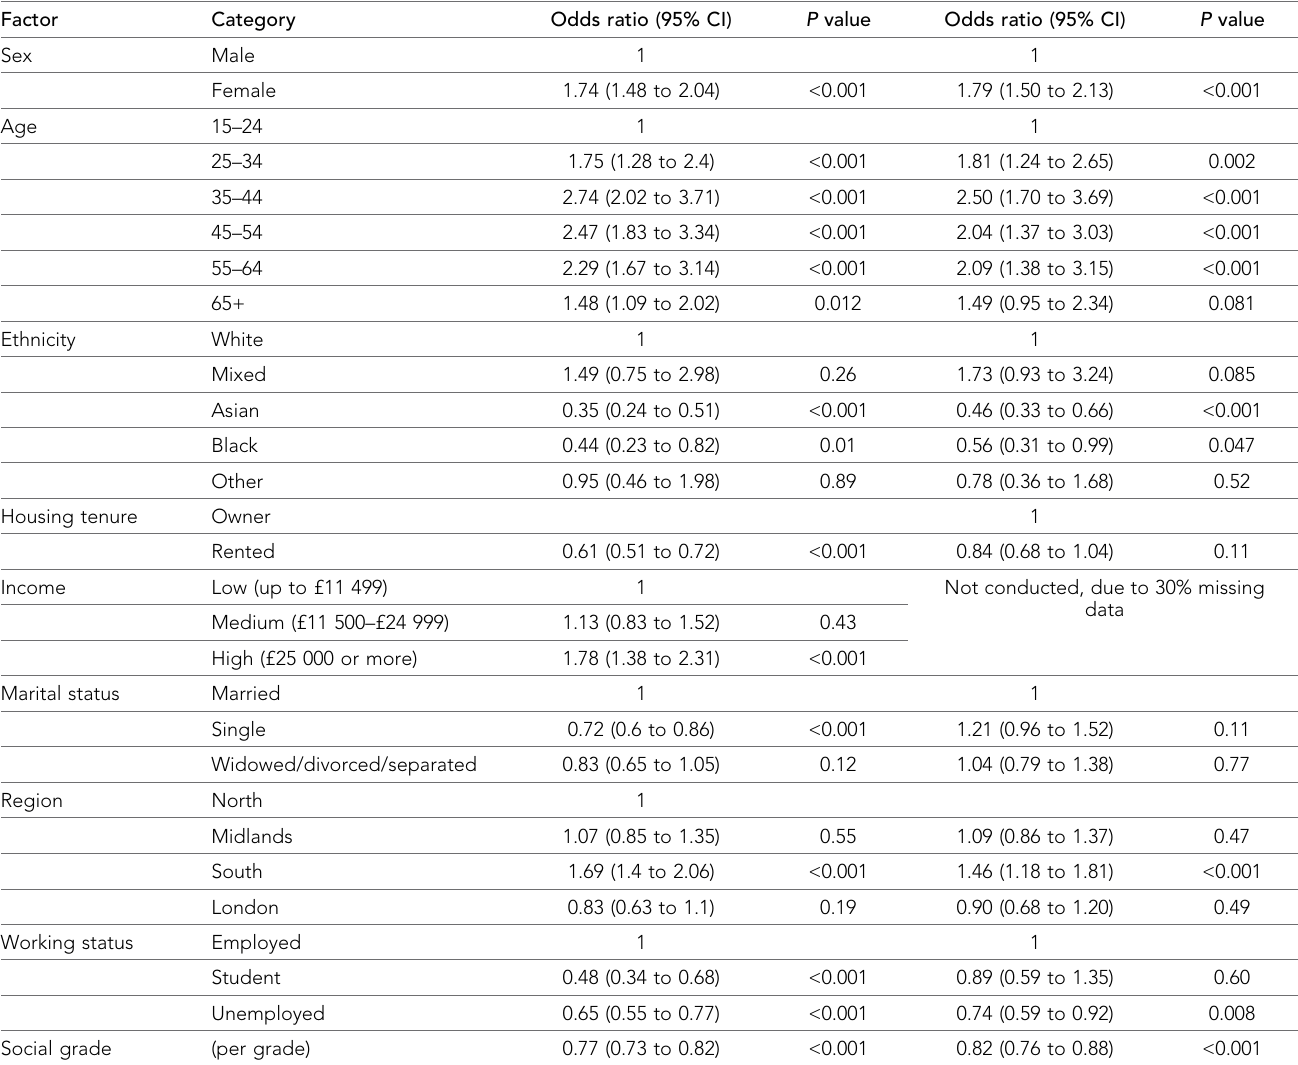
Table 3 Univariable and multivariable associations of overall CAM